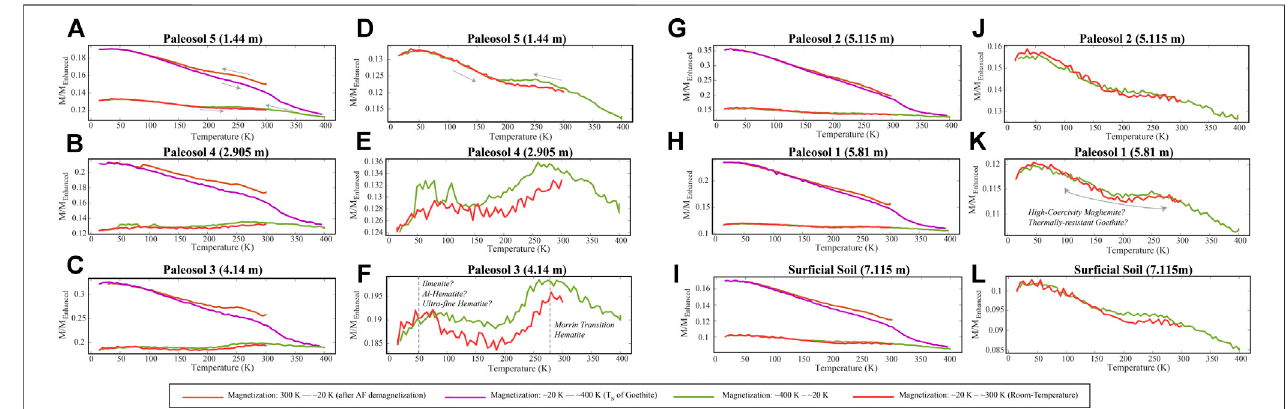
FIGURE9| Low-temperature hematite-goethitetestforallsixsoilsintheBlackwater drawtype-siteafterAFdemagnetizingtheTRMacquiredby fi eldcoolingeach sample from 400 K to 300 K in a 2.5 T fi eld. Brown curve represents cooling from 300 K to ∼ 20 K after AF demagnetization at 300 mT. Magenta curve represents warming from ∼ 20 K to 400 K in order to thermally demagnetize goethite. Green curve represents cooling from 400 K to ∼ 20 K. Red curve represents fi nal warming curvefrom ∼ 20 K to300 K. Figure8A-C and Figure8G-I includesall fourcurvesfor Paleosols5-3and Paleosols2-Sur fi cialSoilrespectively. Notethe difference in magnetization values between the fi rst two curves (brown and magenta curves) and the fi nal two curves in the sequence (green and red curves); the loss in magnetizationinthe fi naltwocurvesisattributedtothethermaldemagnetizationofthegoethitecontributionat400 K. Figure9D-E and Figure9J-L merelyfocusonthe fi naltwocurves(green andredcurves)of Figure9A-C and Figure9G-I ,respectivelysothattheycanbeobservedinmoredetail.Theoreticallythesecurvesshouldonly represent the isolated hematite contribution for each soil specimen although the increase in magnetization with decreasing temperature (evident in Paleosols 5,2,1 and Sur fi cial Soil) indicates that either high-coercivity maghemite was not completely AF-demagnetized or that a goethite contribution was not adequately thermally demagnetized. Nevertheless, all specimens display a Morin transition at ∼ 220 K — ∼ 200 K indicating the presence of hematite. Morin transitions shifted towards lower temperatures,inadditiontothe “ humps ” around ∼ 100 K — ∼ 25 Kareinterpretedtorepresentadistributionofvery fi ne(potentiallynano-sized)hematitegrains(Özdemir et al., 2008; Jiang et al.,